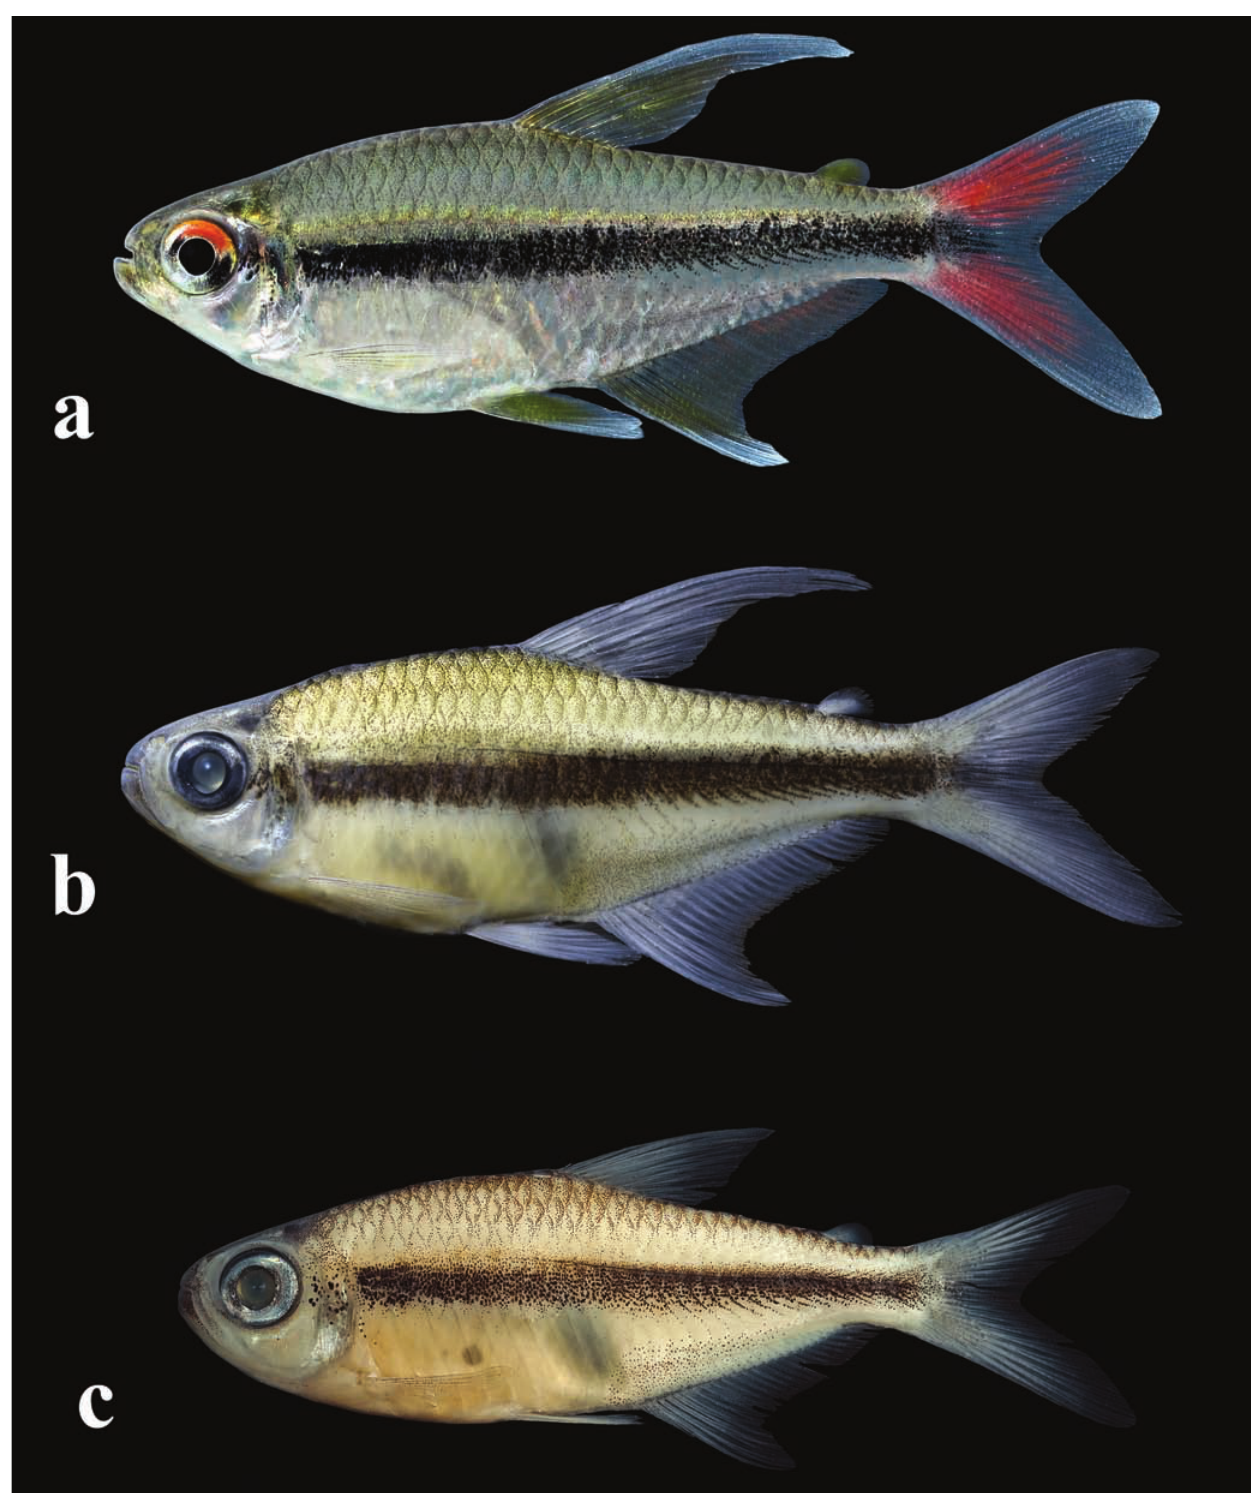
Fig. 1. Hemigrammus ataktos , holotype, MZUSP 113725, 37.7 mm SL, male (a) photographed alive, (b) after preservation; (c) MZUSP 113724, paratype, 33.0 mm SL, female, rio Manoel Alves drainage, rio Tocantins basin, Natividade, Tocantins State,